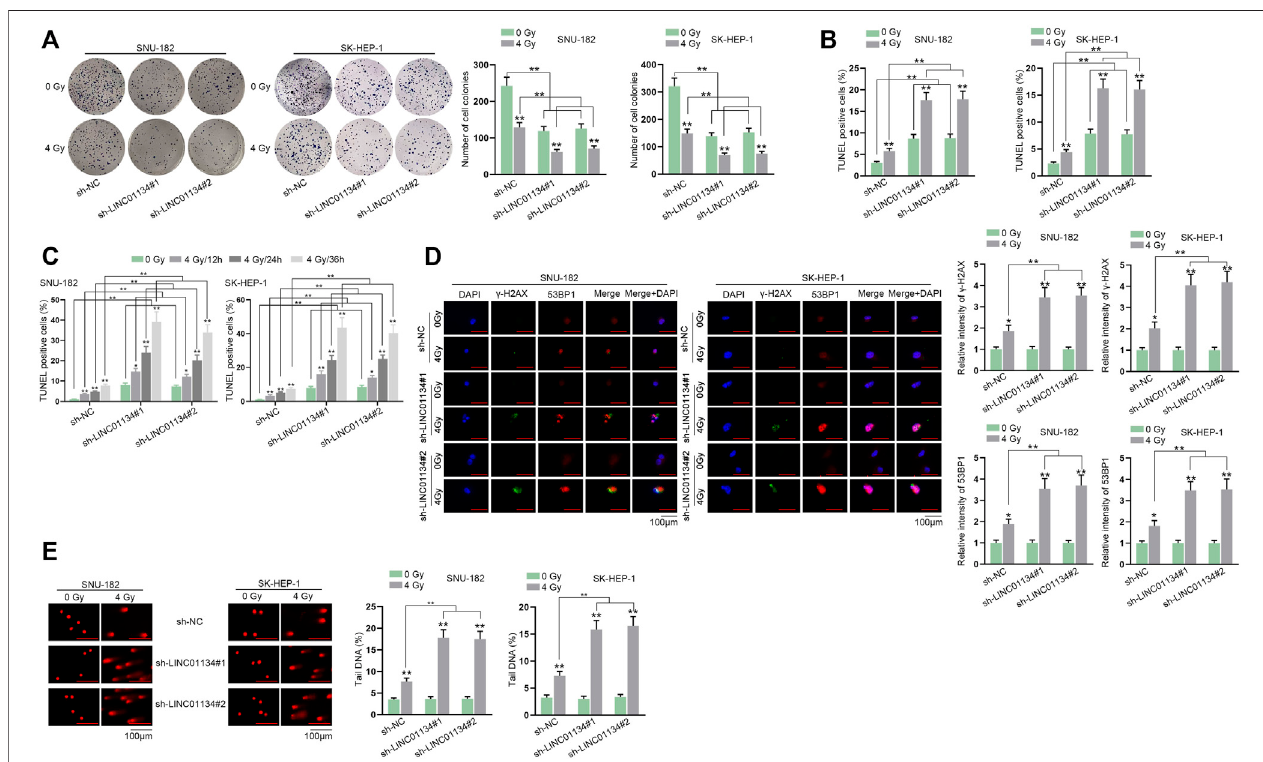
FIGURE 2 | LINC01134 de fi ciency attenuates radioresistance of HCC by promoting DNA damage. (A,B) Colony formation and TUNEL assays were implemented todetectcellproliferationandcellapoptosisunderirradiationof0 Gyand4 Gy. (C) TUNELassaywascarriedoutinHCCcellsexposedto4 Gyradiationatdifferenttime points (12, 24, 36 h). (D) Immuno fl uorescence staining was performed to observe γ -H2AX and 53BP1 foci formation (magni fi cation: 100 × ). (E) Comet assay was conducted to examine DNA repair after LINC01134 was downregulated in HCC cells. * p < 0.05, ** p < 0.01.